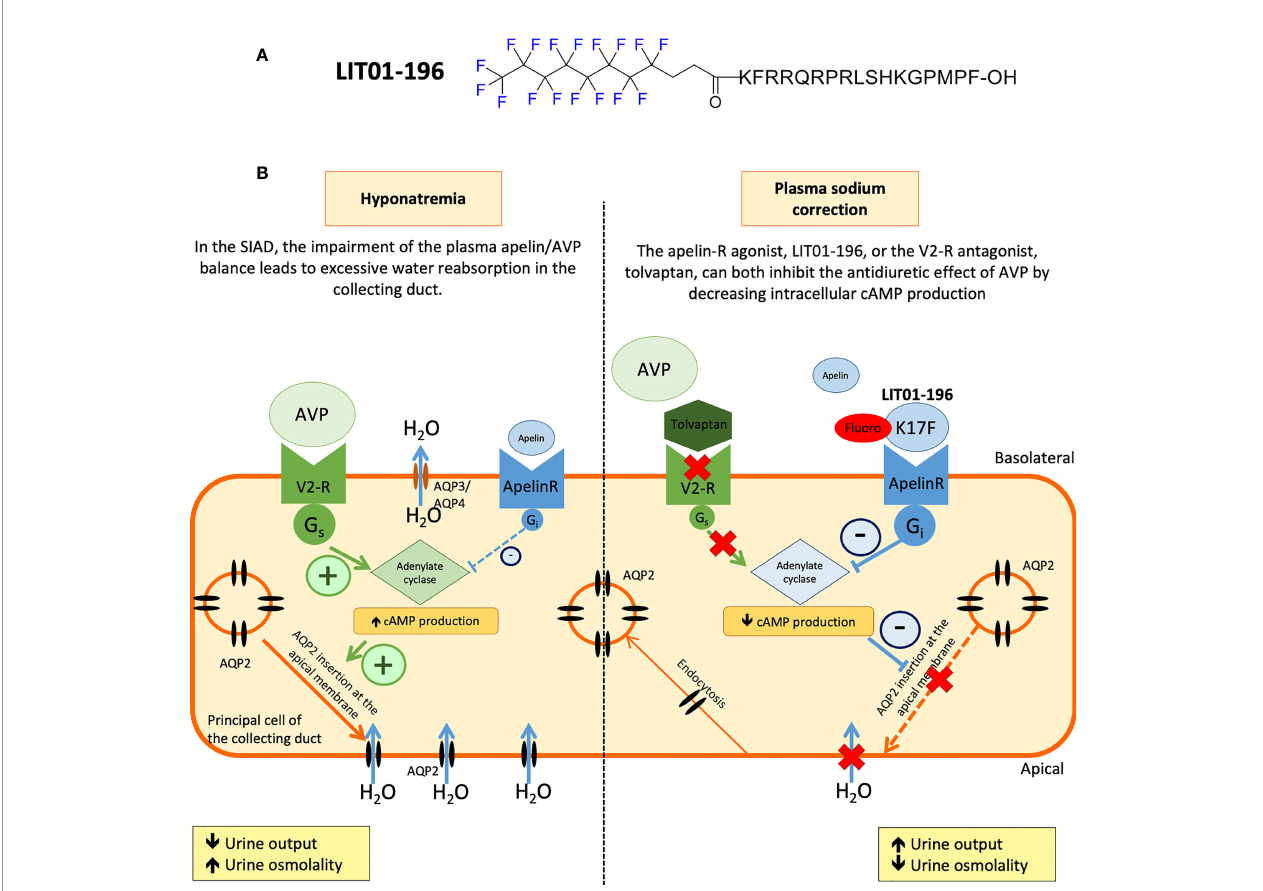
FIGURE 4 | Proposed model of the effects of LIT01-196 on the principal cells of the collecting duct in SIAD. (A) Chemical structure of LIT01-196. (B) Schematic representation of the apelin and vasopressin (AVP). (B) Schematic representation of the apelin and vasopressin (AVP) receptors signaling pathways in the principal cells of the collecting duct (CD). Signaling pathways in the principal cells of the collecting duct (CD). In SIAD, the increase in AVP secretion is inadequate relative to plasma osmolality leading to hyponatremia. Consequently, there is an abnormal apelin/AVP balance in hyponatremic SIAD patients which contributes to water retention. By acting on V2 receptors (V2-R) present in the principal cells of the CD, the increased AVP levels stimulate cAMP production, leading to the insertion of aquaporin 2 (AQP2) into the apical membrane of CD, resulting in higher levels of water reabsorption (H 2 O), lower levels of diuresis, and hyponatremia. In SIAD, LIT01-196, by acting on the ApelinR present in the CD, re-establishes the “ AVP/(apelin + LIT01-196) ” balance and inhibits AVP-induced cAMP production, thereby inhibiting the insertion of AQP2 into the apical membrane of the CD, resulting in the inhibition of water reabsorption by the kidney and an increase in aqueous diuresis. As previously described, tolvaptan, by blocking the action of AVP on the V2-R, induces a similar increase in aqueous diuresis. Figure adapted from Ref. (86) with permission from the copyright